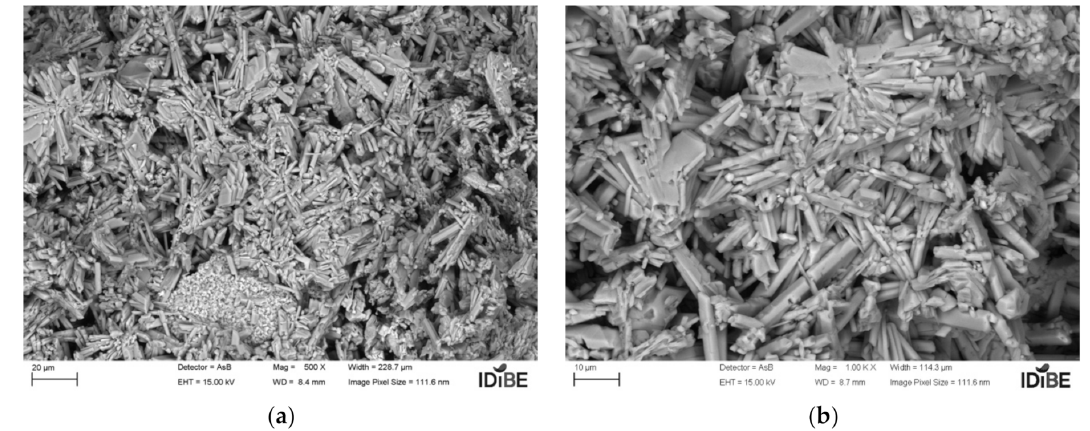
Figure 7. Micrograph of the 0.6% melamine compound (lot C2): ( a ) 20 µ m; ( b ) 10 µ m (source: the author).